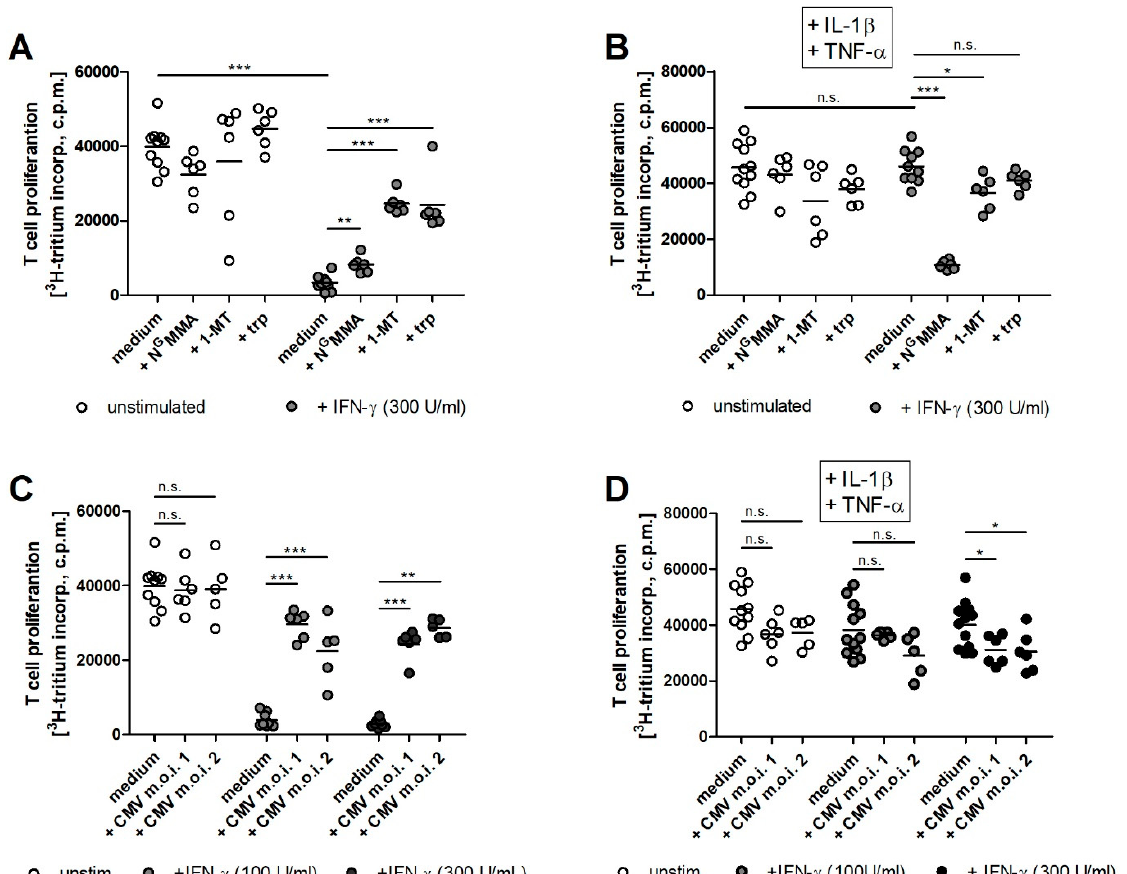
Figure 4. iNOS activity and CMV infection impair IDO1-mediated immunoregulatory effects in human RPE cells. 3 × 10 4 hRPE cells were stimulated in 96-well plates with indicated amounts of human IFN- γ (0 to 300 U/mL) in the absence ( A , C ) or presence of IL-1 β and TNF- α (100 U/mL each) and N G MMA (100 µg/mL) or 1-methyl-tryptophan (1-MT; 1.5 mM) or L -tryptophan (trp; 100 µg/mL).